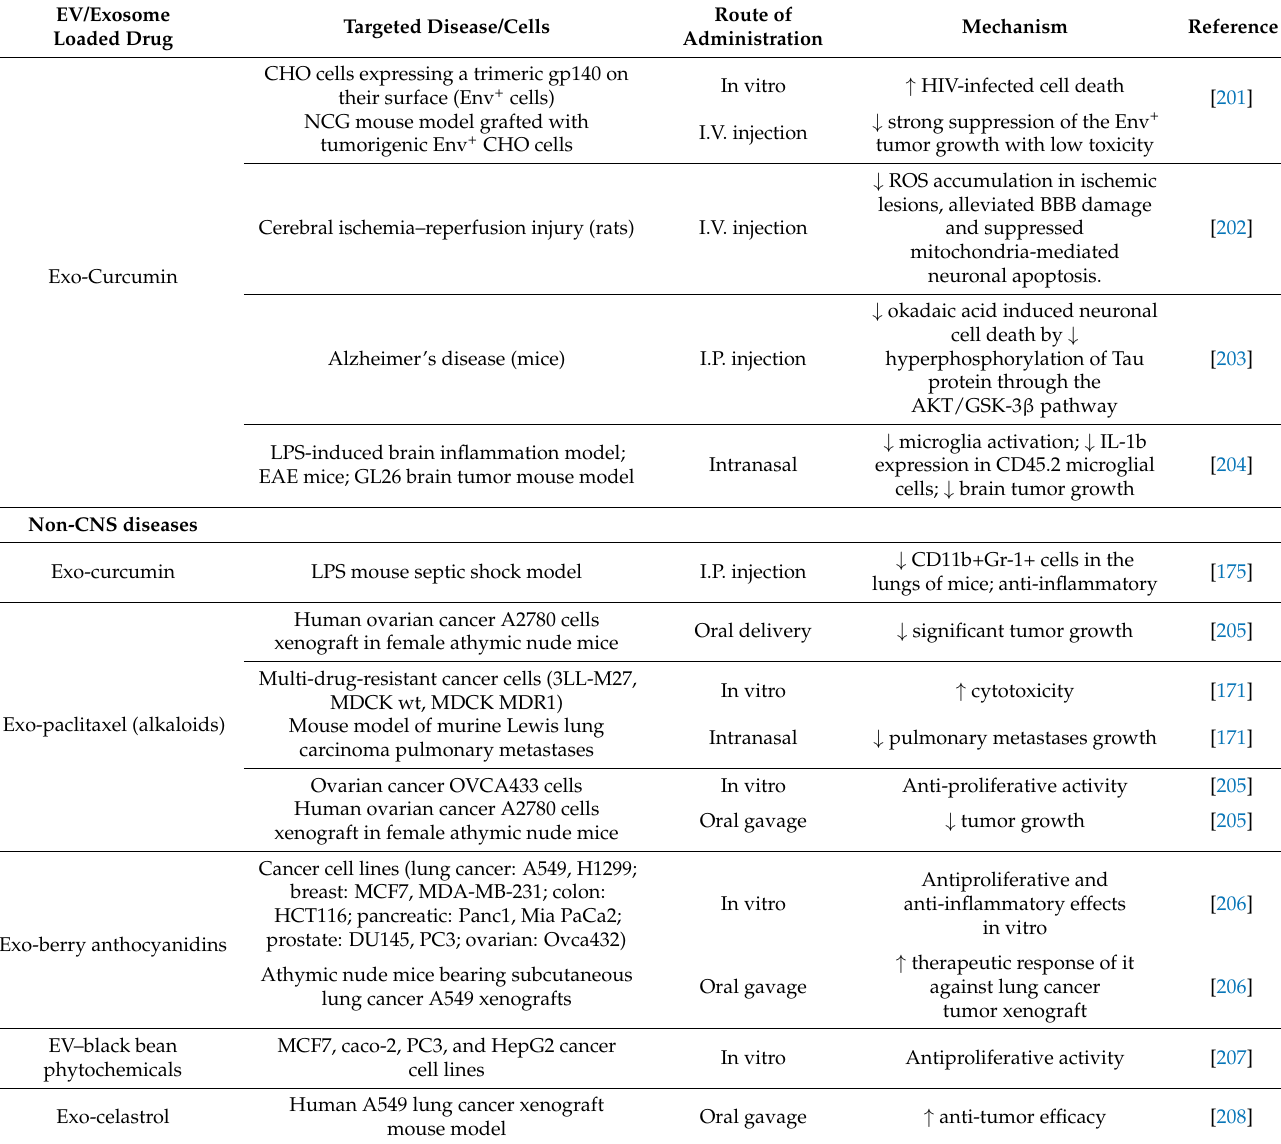
Table 3. EVs/exosomes loaded nutraceutical agents-based therapies for HIV and other CNS